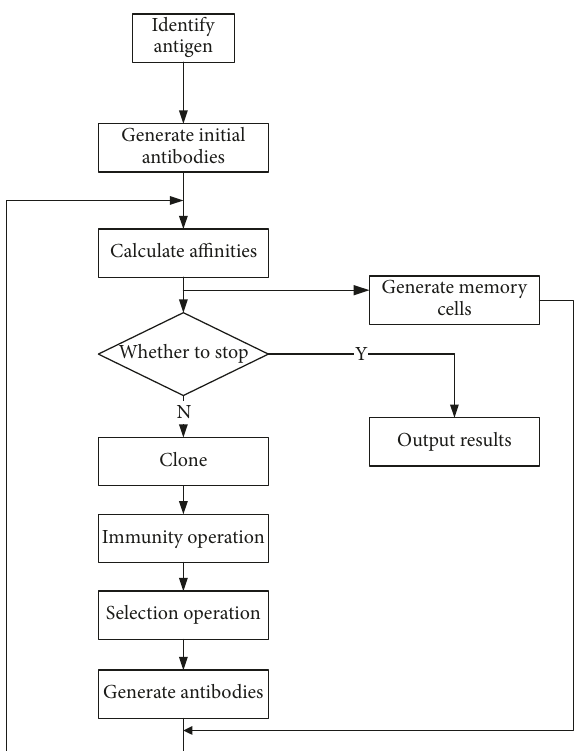
Figure 2: Flowchart of cloud clonal selection operation.